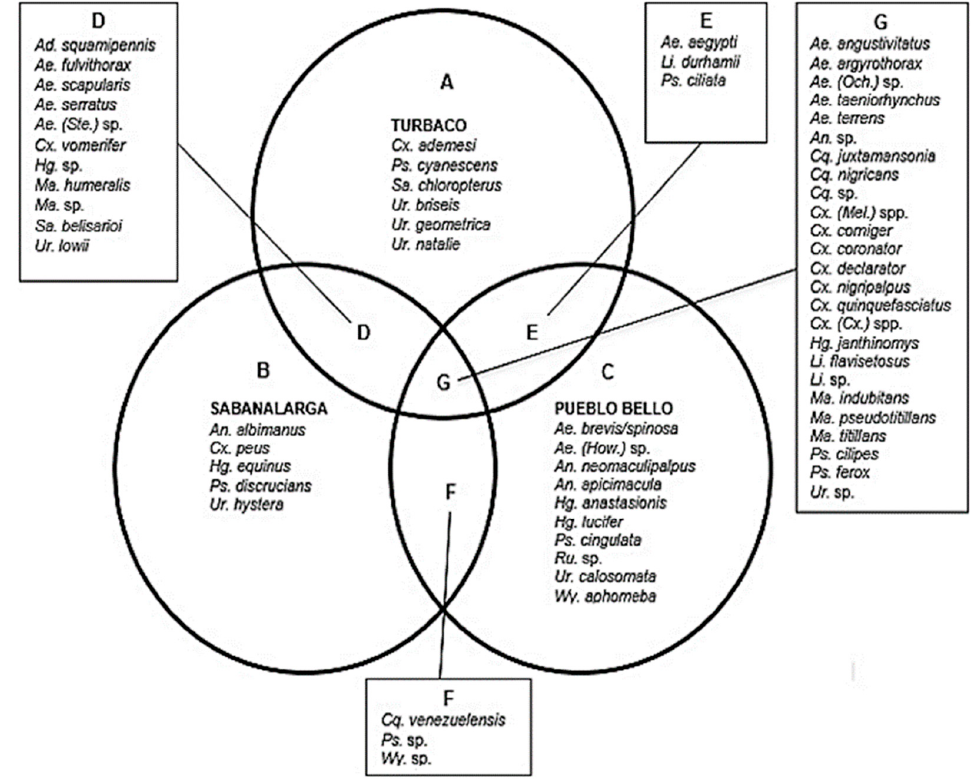
Figure 2. Venn diagram showing the distribution of species found in the different